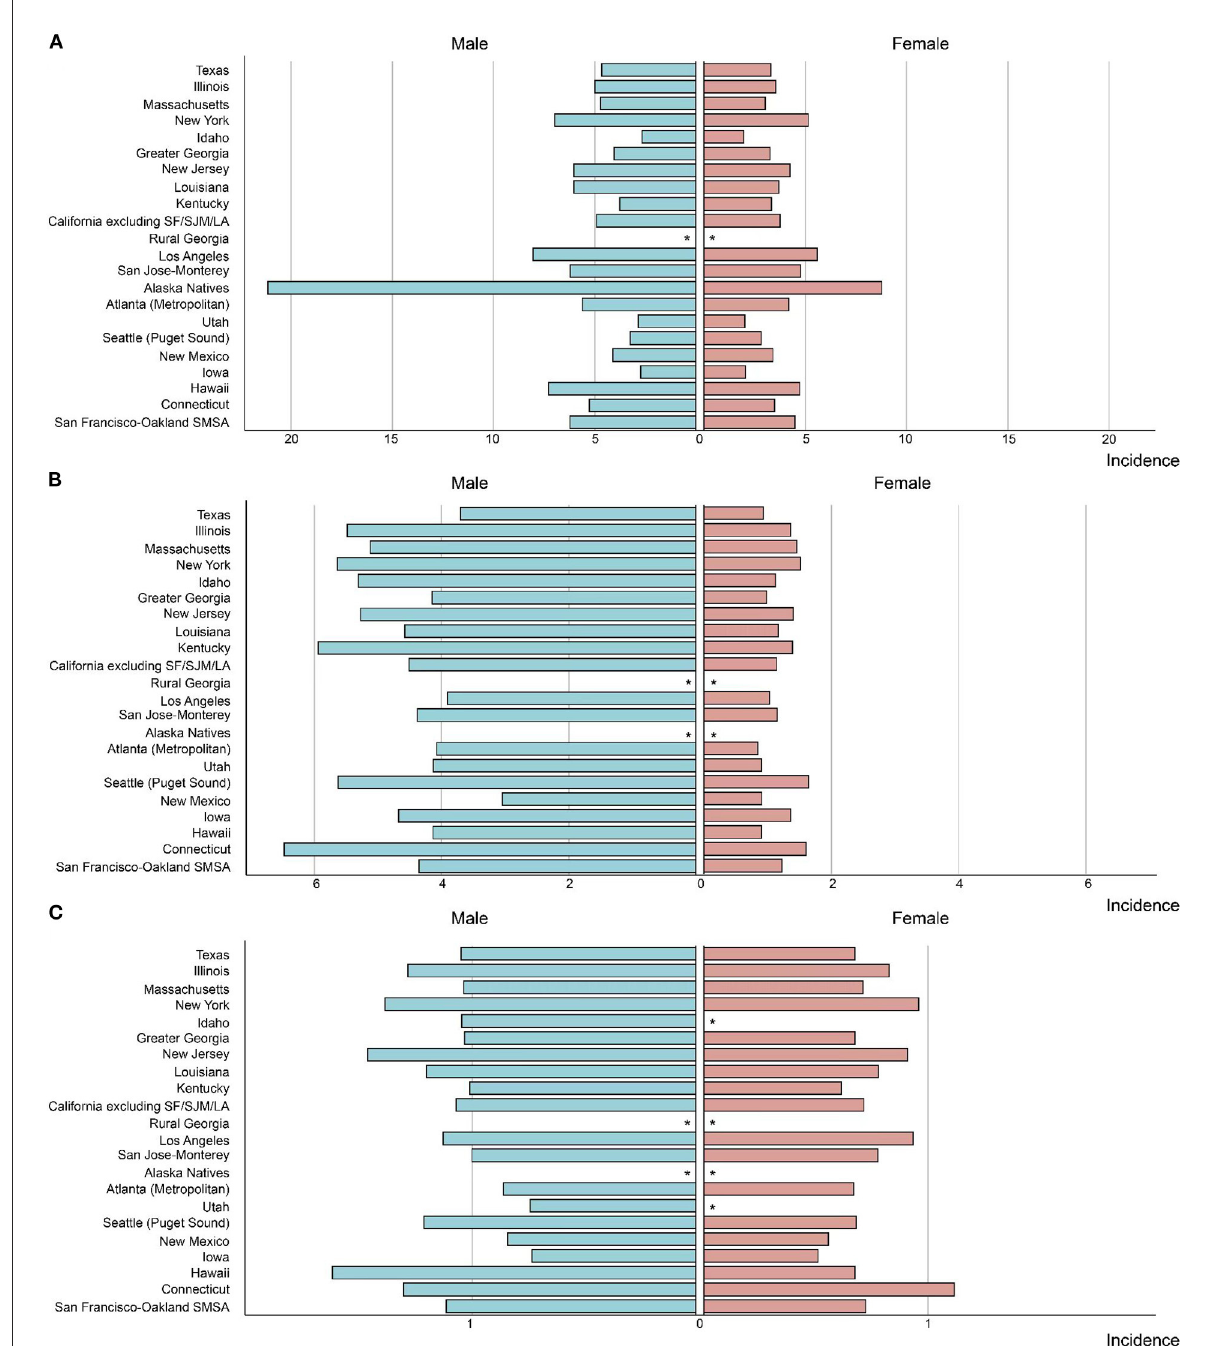
FIGURE3 The incidence rate in Helicobacter pylori related malignancy among US adults by SEER registry and sex, 2015–2019 (A) non-cardia gastric cancer, (B) cardia gastric cancer, (C) gastric non-Hodgkin lymphoma. “ * ” indicates that the number of observed cases was < 16 and the incidence was not estimated due to small sample